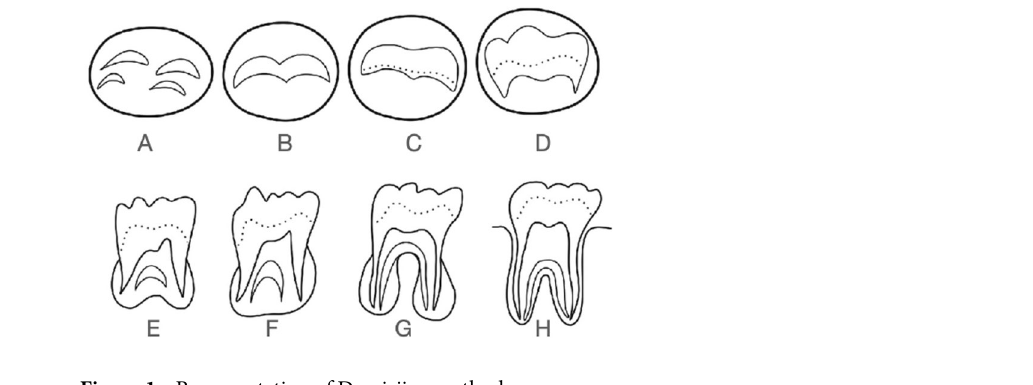
Figure 1. Representation of Demirjian